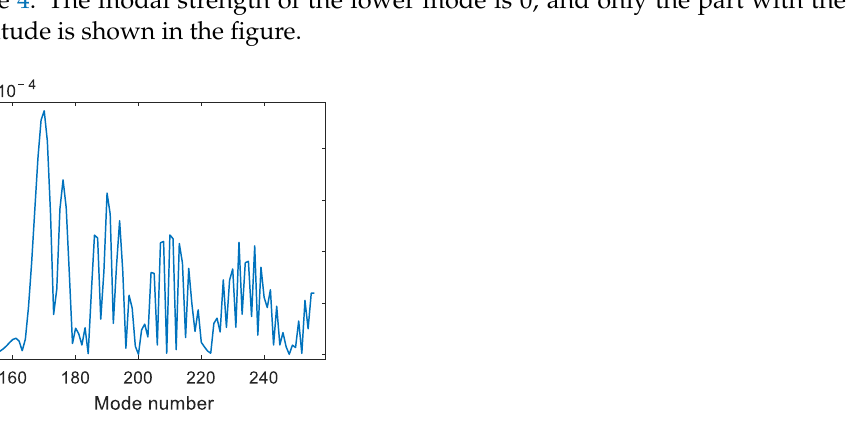
Figure 4. Mode amplitudes for refracted and surface-reflected modes considering linearly varying sound speed. Figure 4 shows that mode 170 yields the strongest modal intensity at the receiver depth. Computationally, the spread in mode n is defined by two successive minima in the figure (i.e., 10 n = ). Table 1 lists the positions of the convergence zones calculated using Equation (20) and the coupled normal mode.